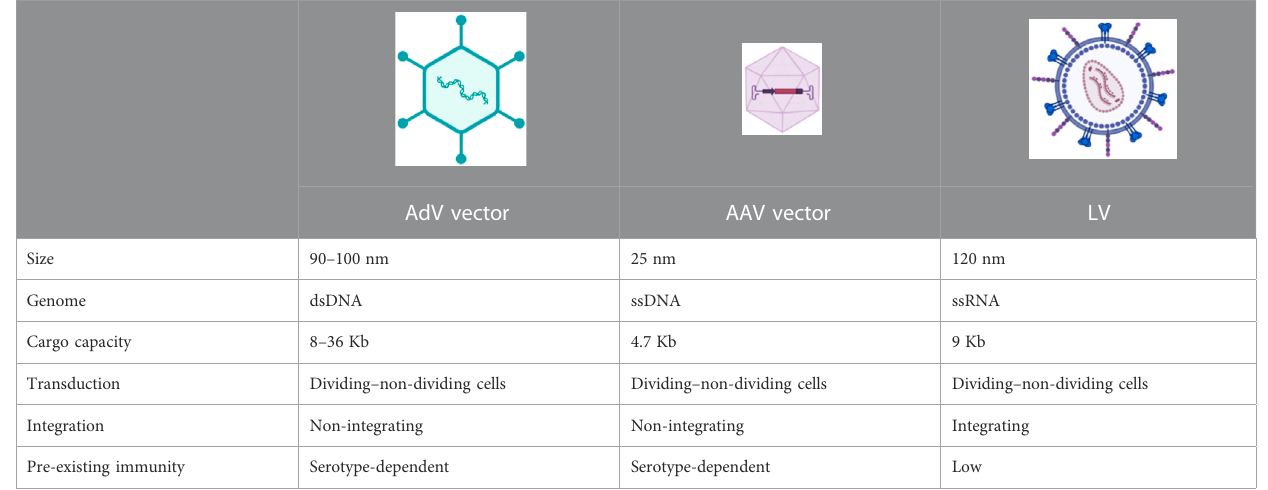
TABLE 2 Main viral vectors used for in vivo gene